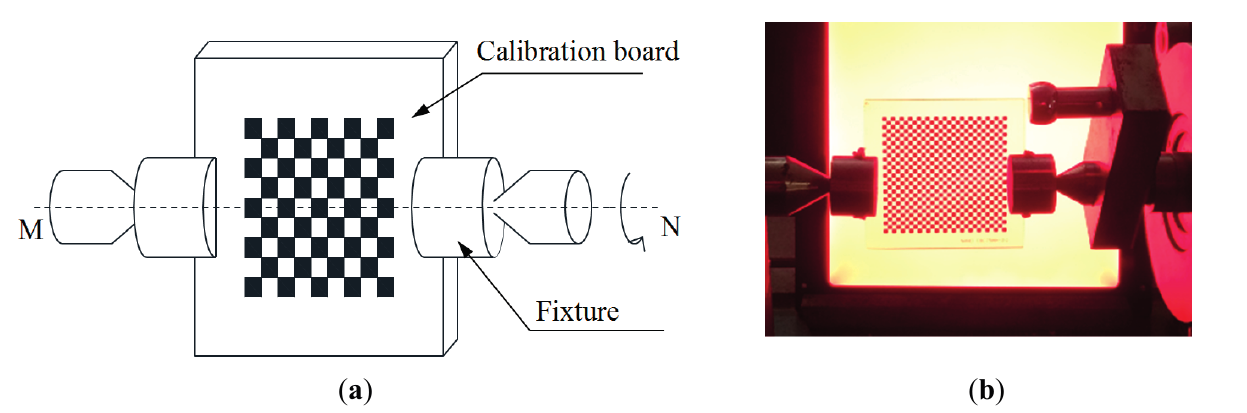
Figure A1. The model of the calibrating axis. ( a ) sketch map; ( b ) image of